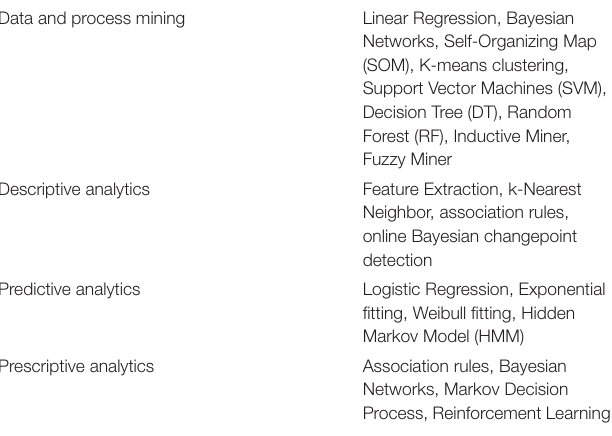
TABLE 7 | The algorithms implemented in the platform. Data and process